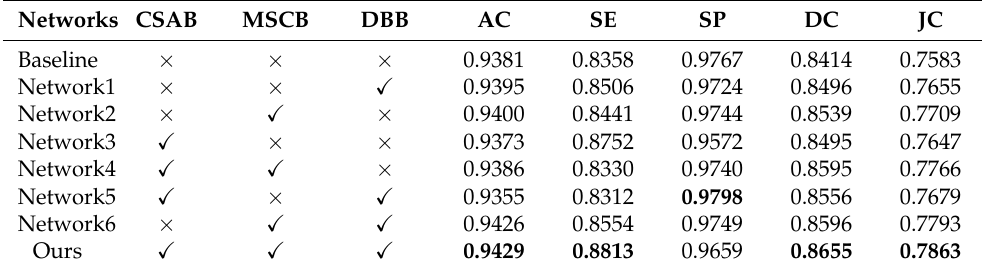
Table 8. Ablation experiment results on the ISIC-2017 dataset.